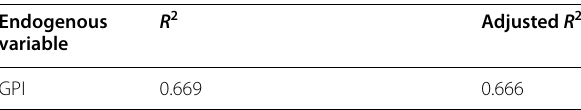
NB diagonal values which have been highlighted are square root of AVE, while the rest are inter‑construct correlations Table 4 R 2 results